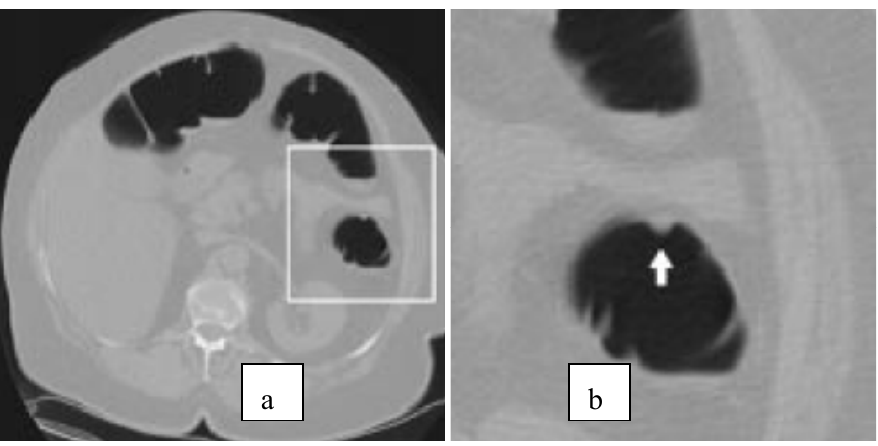
Figure 3. Effect of Shape Index in Differentiating